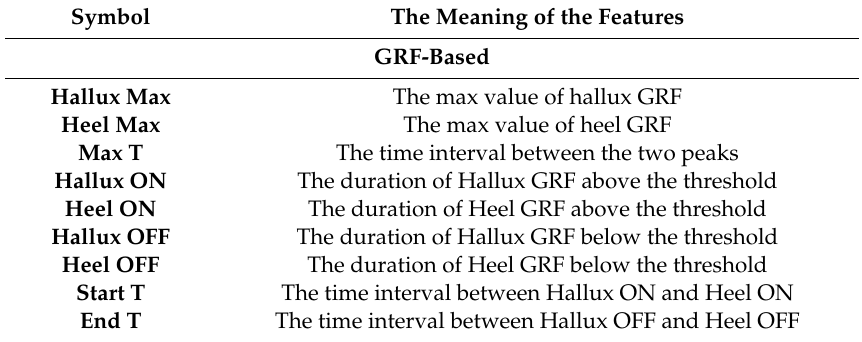
Table 3. Extracted features of the EMG and GRF, where i is the index of EMG filtered amplitude and N is the length of the sequence in a